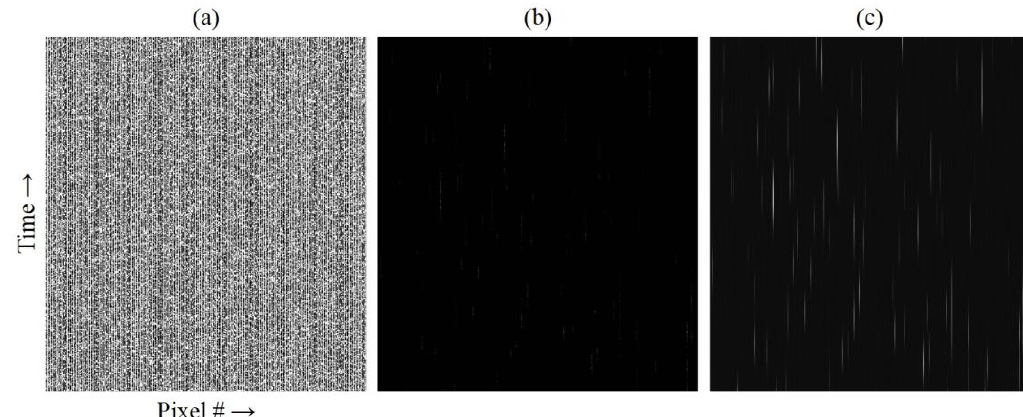
Figure 5. M-file script assessment of simulated fluorescence data. ( a ) The array has been reshaped and the background subtracted; ( b ) the data in (a) has been normalized; ( c ) a matched digital Gaussian filter has been applied to the data in (a) and the result normalized. Only a portion of the total data collection time is